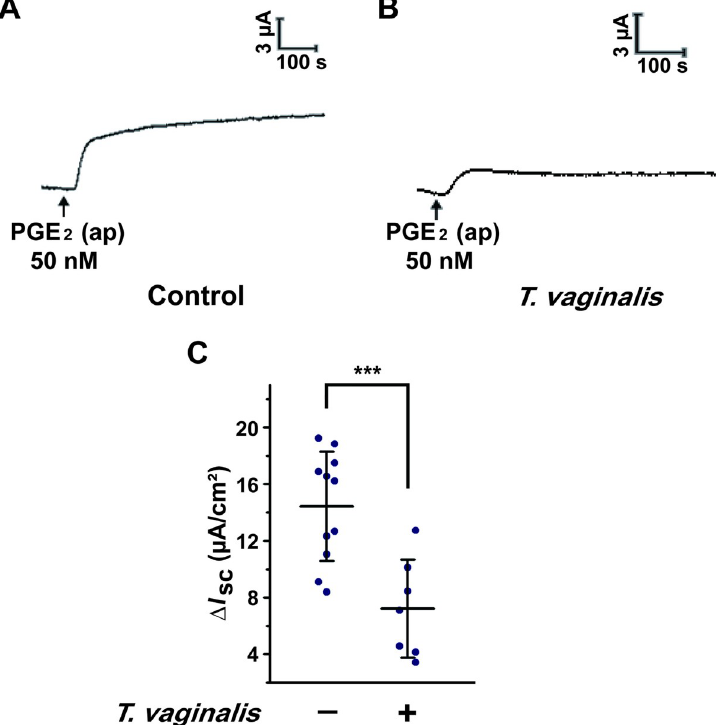
Fig 2. Trichomonas vaginalis infection impaired the anion transport induced by prostaglandin E 2 (PGE 2 ) in rat vaginal epithelium. (A-B) Representative trace showing the short-circuit current ( I SC ) response induced by apical (ap) PGE 2 (50 nM) with (B) or without (A) intravaginal T . vaginalis infection in rats. (C) Statistical analysis showing the effect of T . vaginalis infection on the I SC currents induced by apical PGE 2 (50 nM) in rat vaginal epithelium. Symbols and bars indicate the mean ± S.D. ( n = 7–11, ��� P <